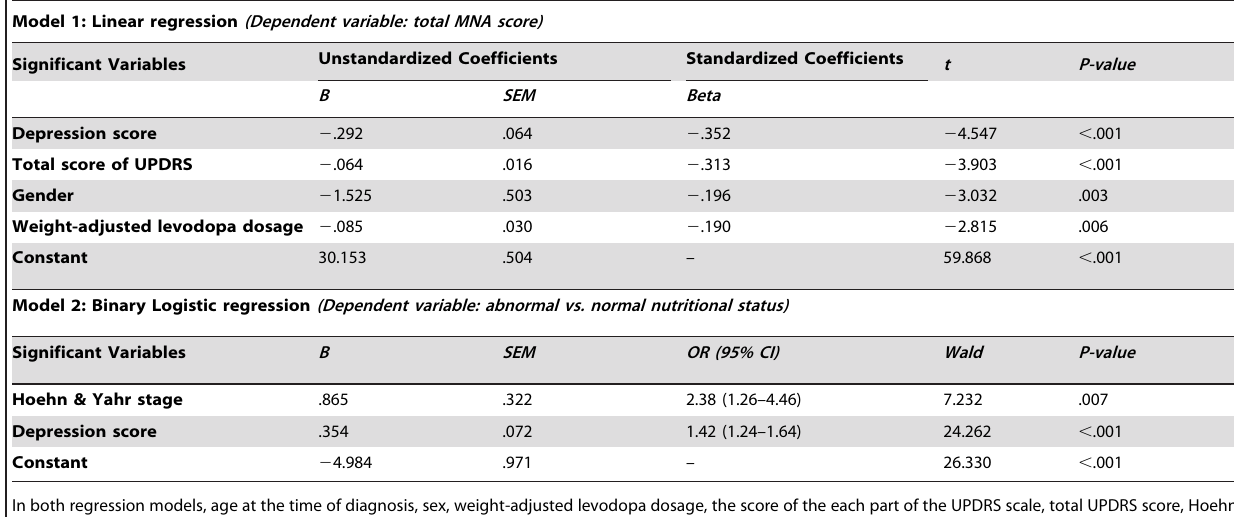
Table 5. Multivariate regression models to determine the motor and non-motor factors independently related to total score of the MNA questionnaire (model 1) and having abnormal versus normal nutritional status (model 2) in recruited Parkinson’s disease (PD)